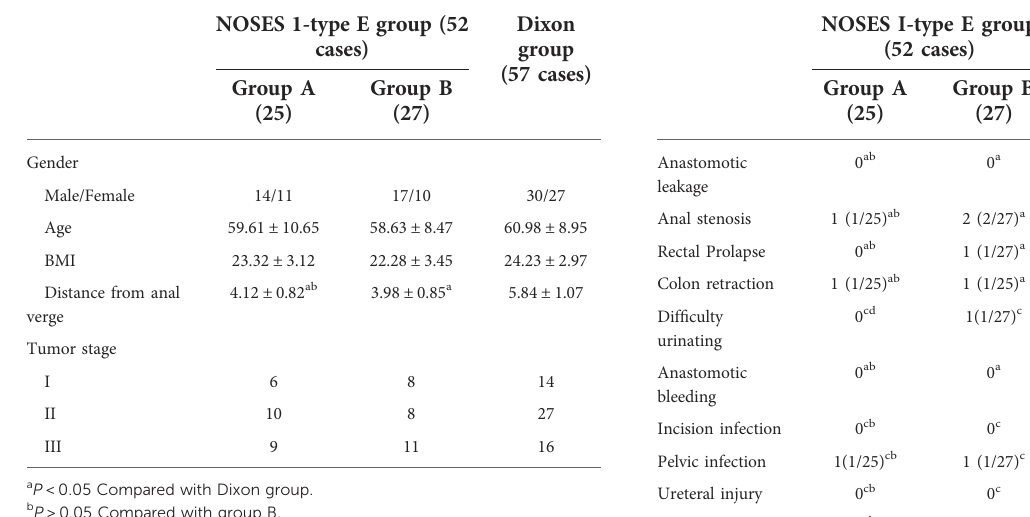
TABLE 1 Comparison of the general data of the four groups.